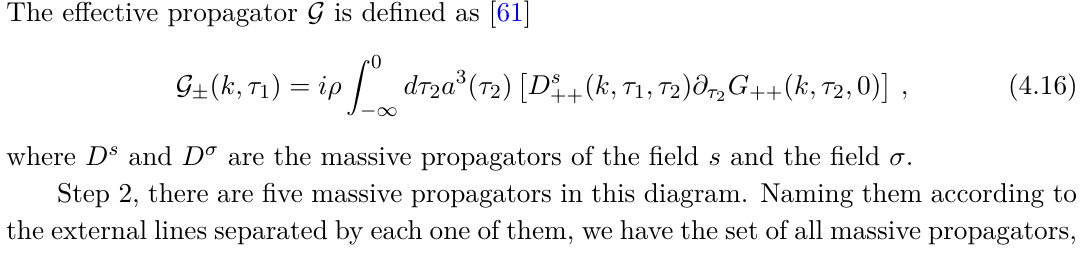
JHEP03(2022)181